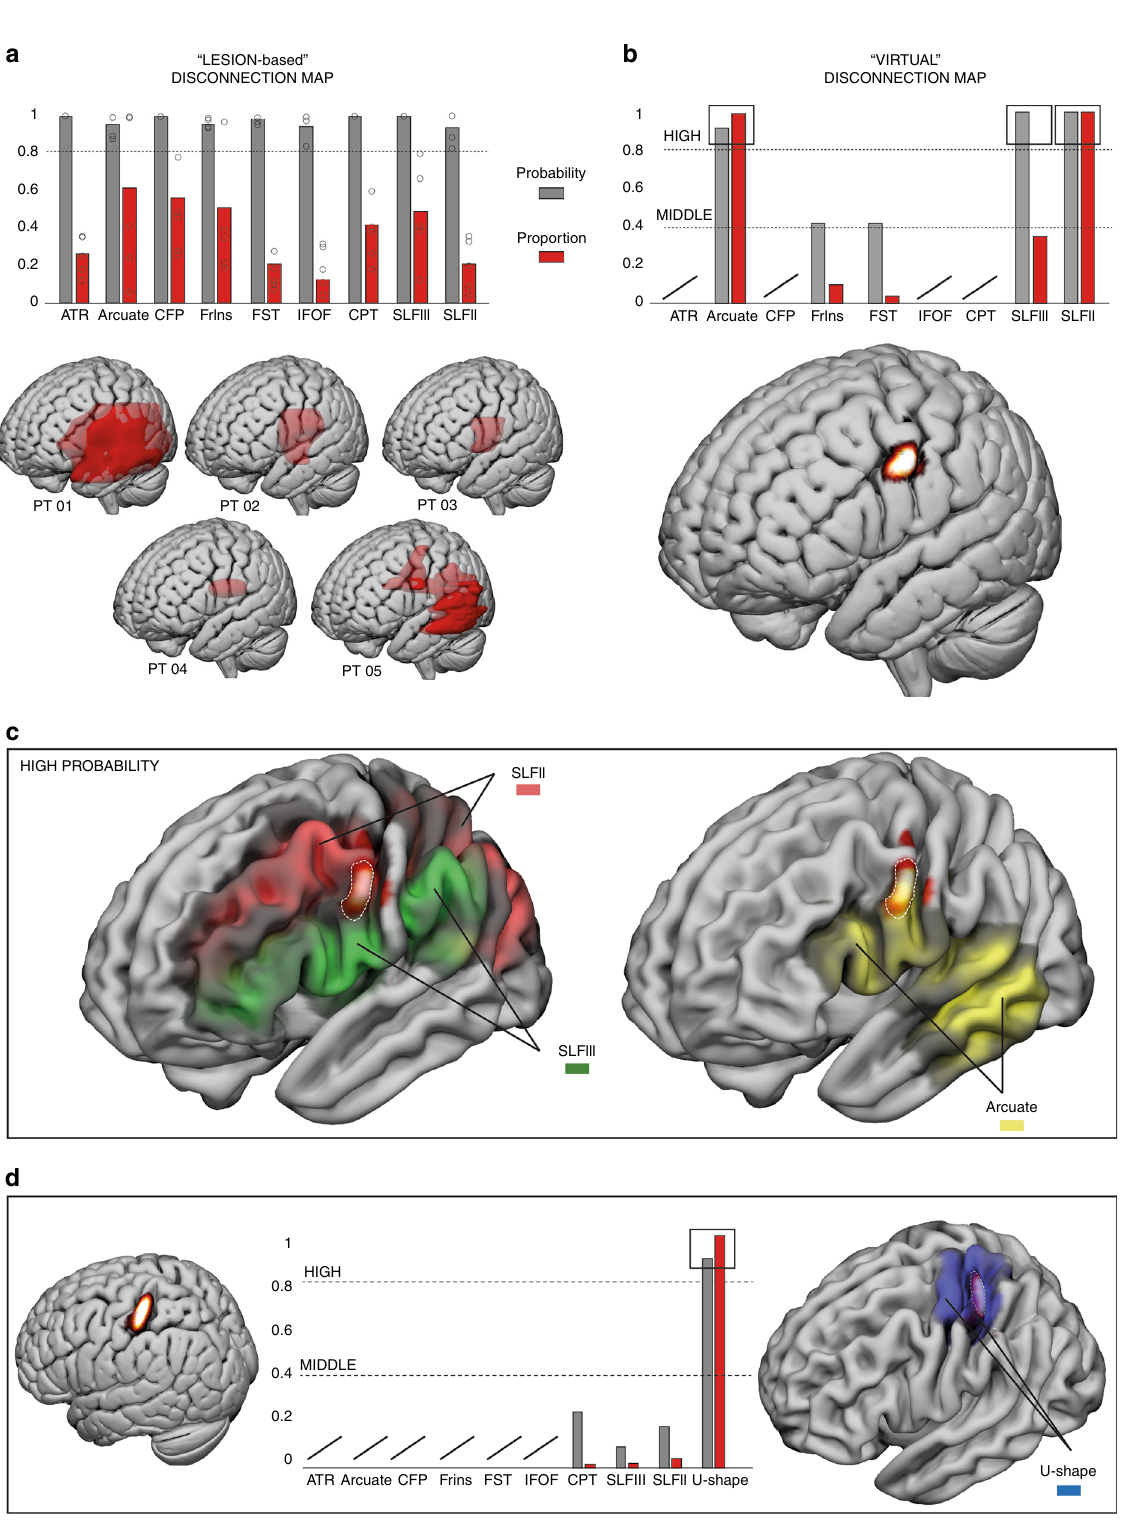
Fig. 4 Disconnection results. Results for the lesion-based ( a ) and virtual-lesion ( b ) disconnection analysis. In the bar graphs we showed the probability (gray) and the voxels proportion (red) of the tracts disconnected in all fi ve AHP patients with a minimum probability of 80%. Below the bar graphs the lesion of the fi ve AHP patients ( a ) (each circle-dot corresponds to patient probability for each tract) and the probability density estimation from which we extracted the virtual-lesion volume ( b ). Both are plotted on the ICBM152. c Anatomical relationship between the PMC virtual lesion and the SLF II – III and the arcuate plotted onto the smoothed ICBM152. d Anatomical relationship between the S1 virtual lesion and U-Shape fi bers connecting postcentral and precentral